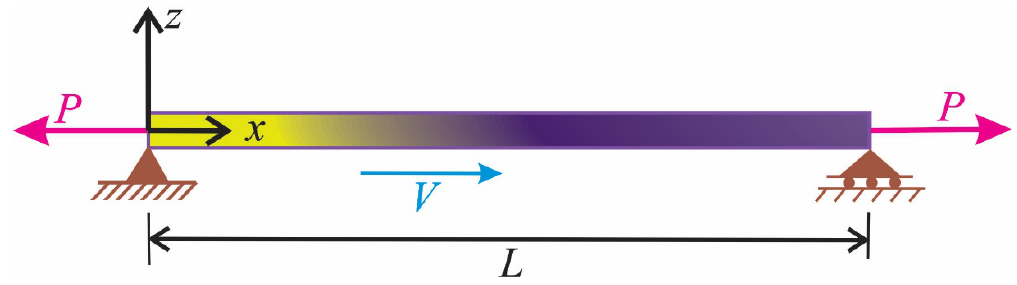
Figure 1. Schematic view of a moving axially functionally graded (AFG) nanobeam.